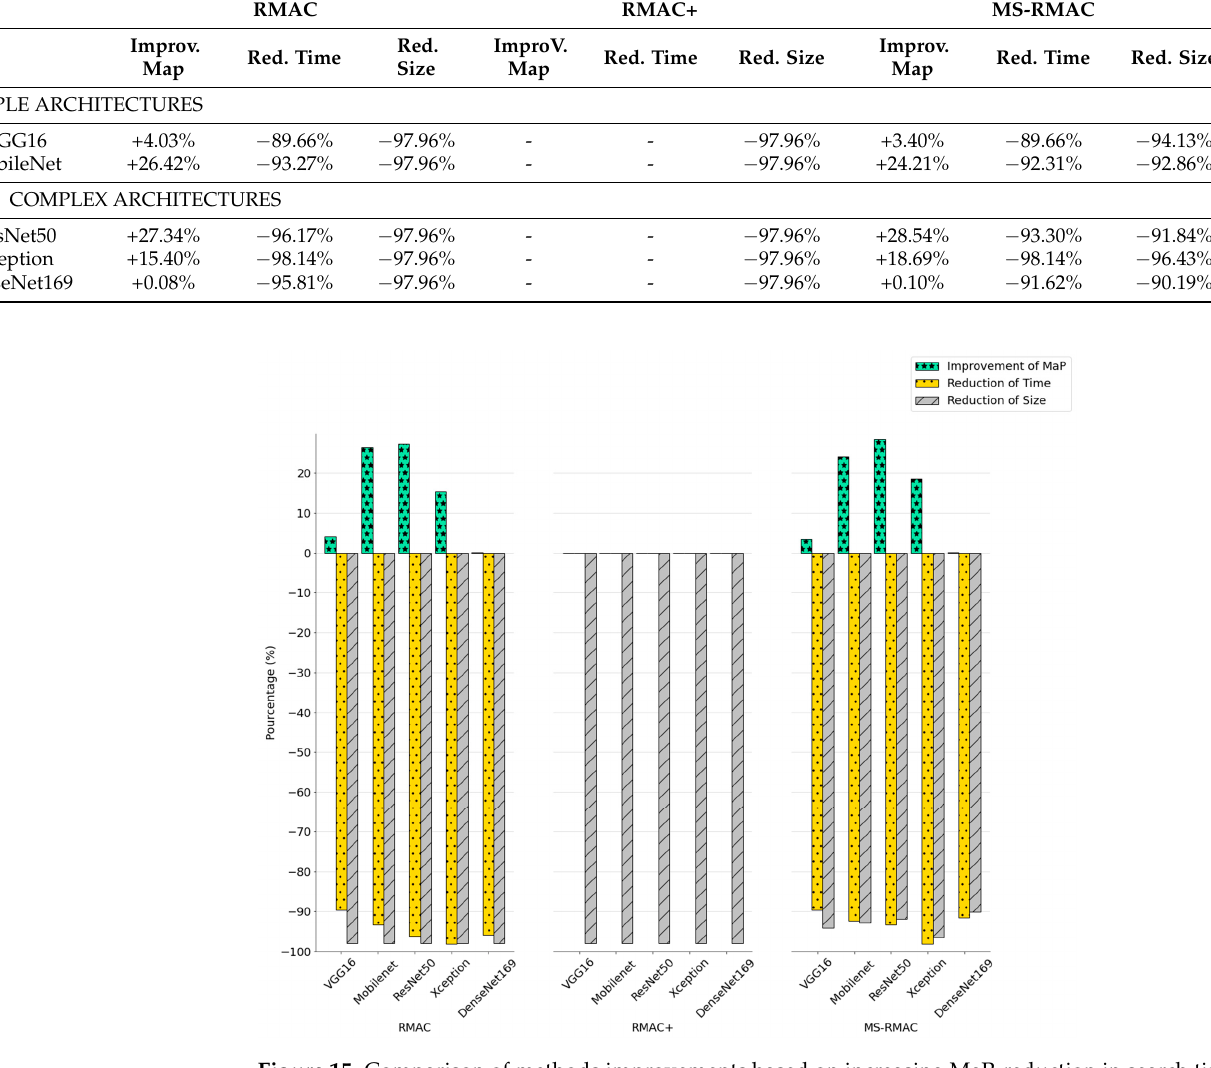
Figure 15. Comparison of methods improvements based on increasing MaP, reduction in search time, and reduction in size vector (%).